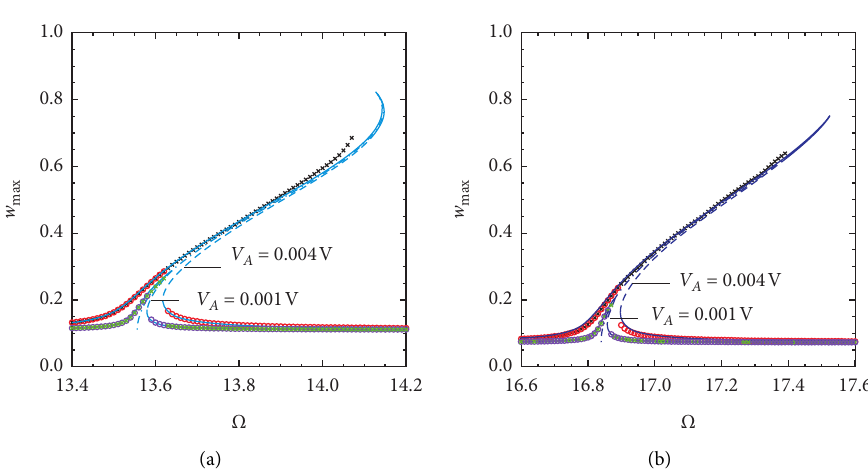
Figure 16: Amplitude-frequency curve: V